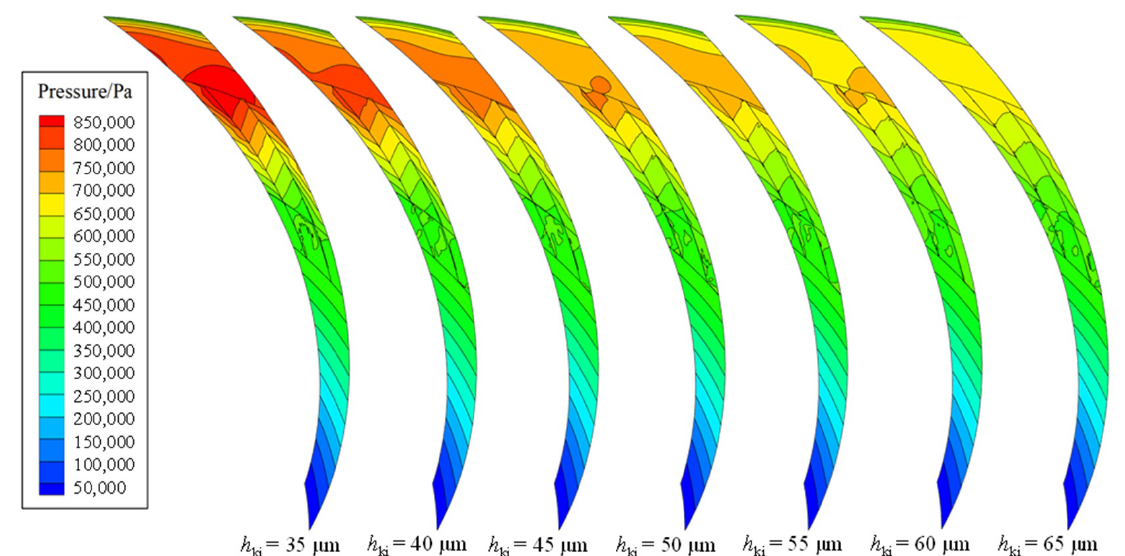
Figure 11. Film pressure cloud chart of the diffuser groove with different depths. ( r k = 34 mm, r o = 30.6 mm, N g = 32, γ = 0.5, λ = 0.9, α = 30°, Δ p = 0.5 MPa, n = 6000·r·min − 1 ).